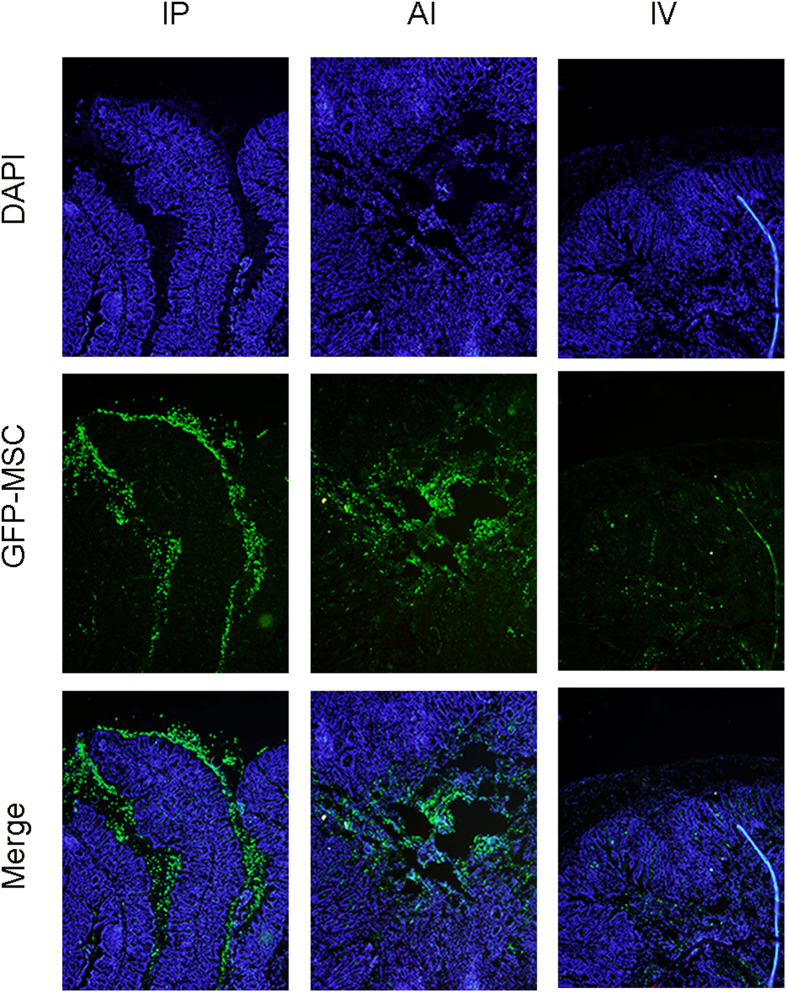
Distribution of GFP+ MSCs in colon 1 day after injection.GFP+ cells were detected at the inflamed colon. In IP group, cells were found accumulation at the epithelium; In AI group, cells were mainly in the lumen; In IV group, cells were fewer and located in lamina propria.